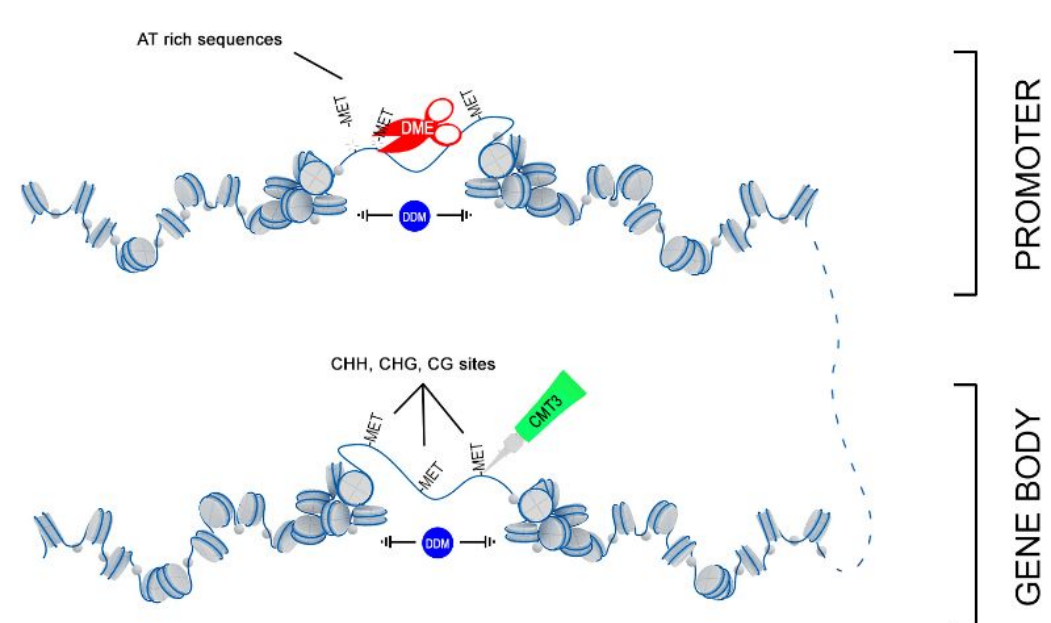
Figure 9. Proposed scheme of joint action of DDM1, DME, and MET3 genes in DNA remodeling.